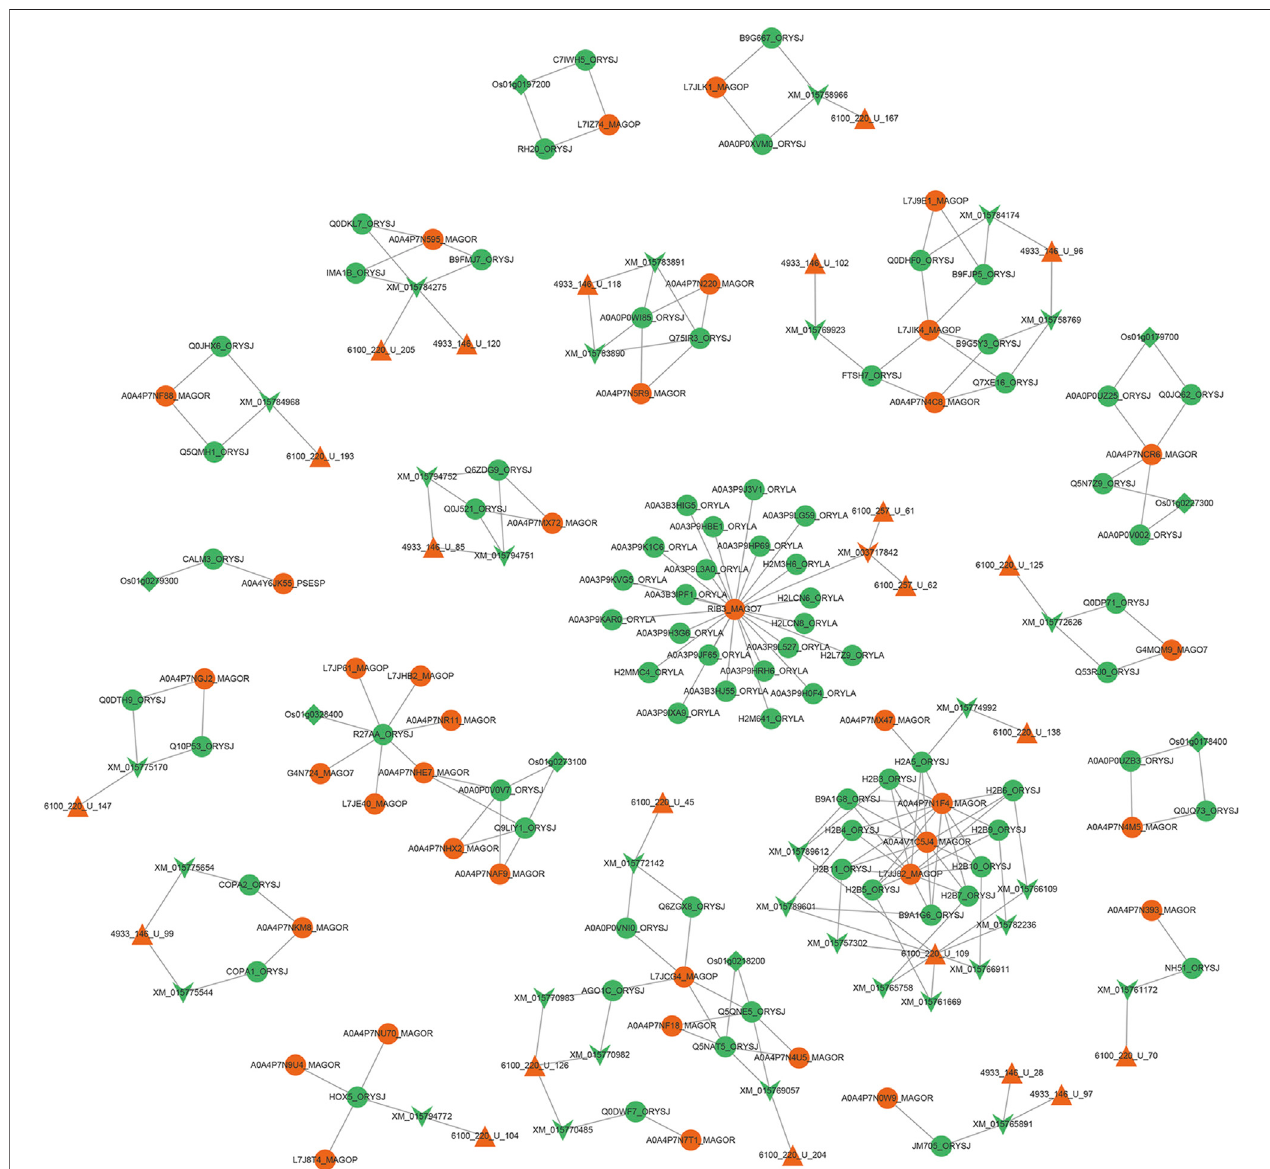
FIGURE9| Interaction networkdiagram between M.oryzae and ricemain regulatoryfactors. Thered regular triangles arethe sRNA nodes of M. oryzae , thegreen inverted triangles are the mRNA nodes of rice, the red inverted triangle is the mRNA node of M. oryzae , the green circles are the protein nodes of rice, the red circles are the protein nodes of M. oryzae , and the green diamonds are the gene nodes of rice. According to the screening of degree and betweenness, the key protein nodes can be found as RIB3_MAGO7, L7JCG4_MAGOP, A0A4P7NCR6_MAGOR, L7JIK4_MAGOP, HOX5_ORYSJ and R27AA_ORYSJ. The key mRNA nodes can be found asXM_015784275 andXM_015765891.ThekeysRNA nodes canbefoundas4933_146_U_99 and6100_220_U_126.Thekeygeneticnodes canbefoundas Os01g0178400 and